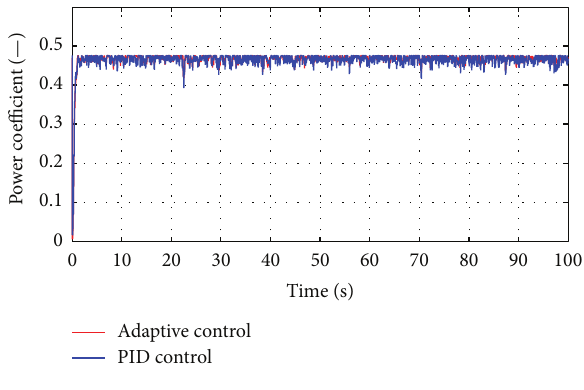
Figure 13: Power